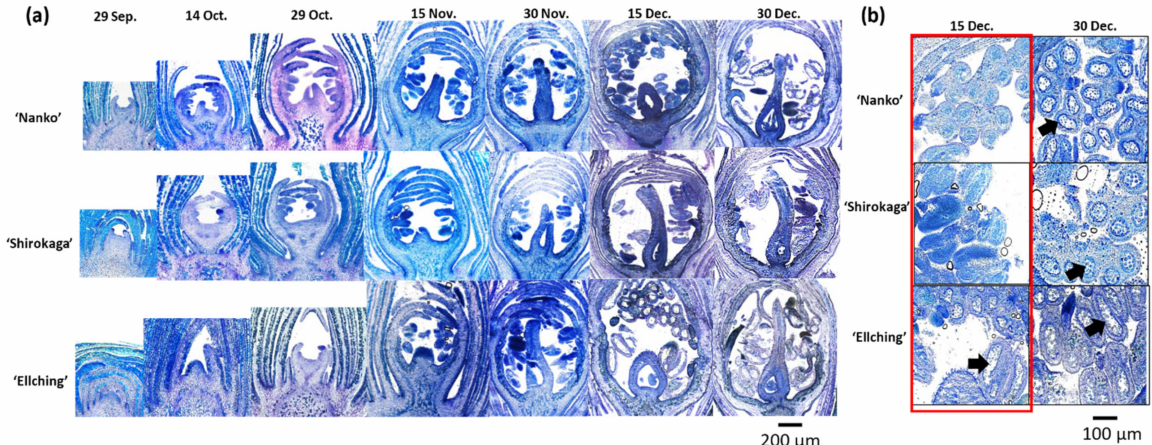
Figure 8. Longitudinal sections of the floral buds from different Japanese apricot cultivars during dormancy. ( a ) Floral organ: A, anther; C, carpel; P, petals; O, ovary. Scale bar = 200 µ m. ( b ) Differences in pollen developmental status among cultivars. Scale bar = 100 µ m. ‘Nanko’, high chill; ‘Shirokaga’, extra high chill; ‘Ellching’, low chill.